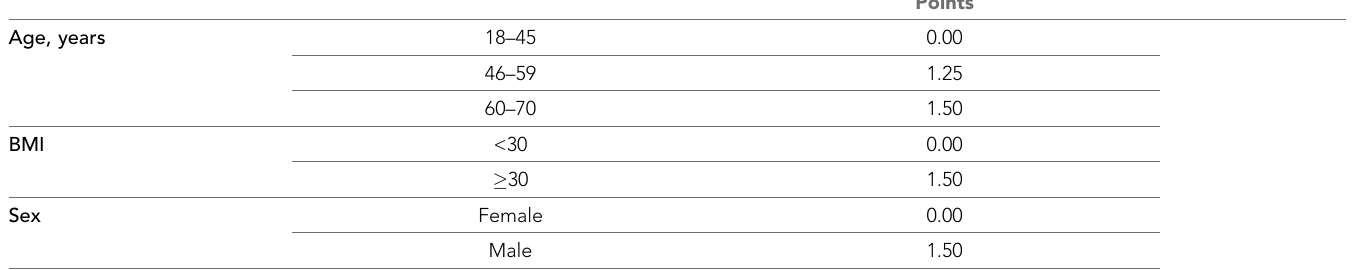
Table 1. Clinical prediction rule in the format it would be used in primary